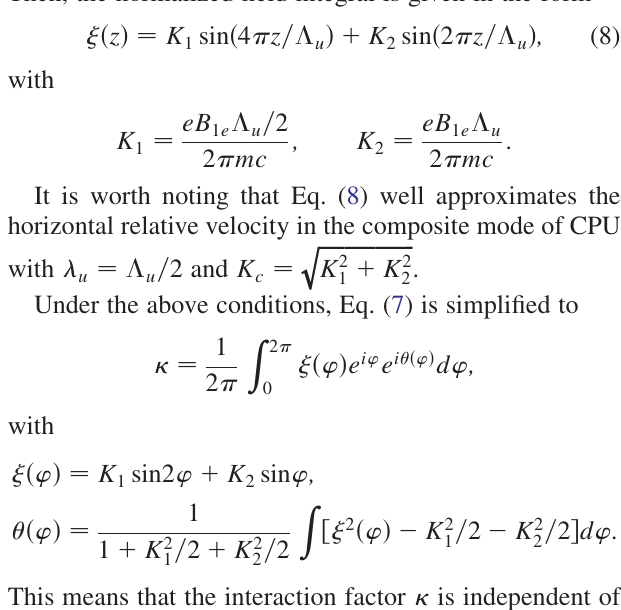
FIG. 4. Gain length growth due to the contribution of the half-period components for different values of K of K 1 =K 2 mean the larger contribution of the half-period